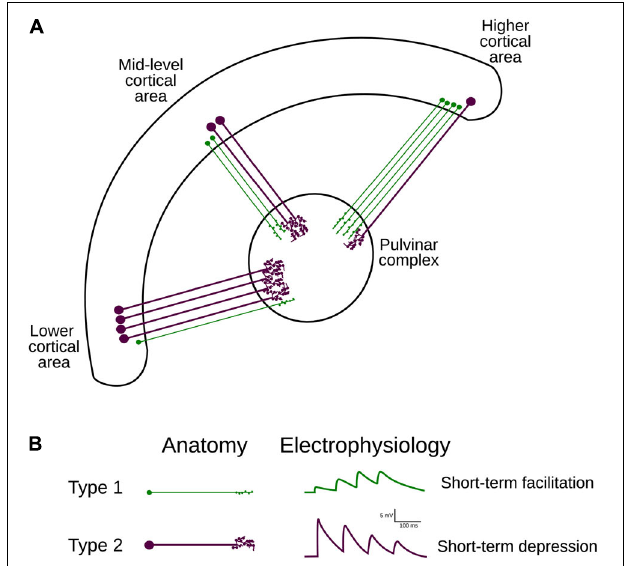
FIGURE 1 | Hierarchical organization and attributes of CT projections. (A) Two types of CT projections from lower- mid- and higher-ranked cortical areas target the pulvinar. Note the variation of proportions of type 1 (from layer VI) and 2 (from layer V) axons along the visual cortical hierarchy ( Table 1 ). (B) Anatomical (left panel) and functional (right panel) classification criteria for projection types 1 and 2. Type 1 terminals have thinner axons, bear small boutons, and elicit EPSP with short-term facilitation; type II projections have thicker axons, larger boutons that can form rosette-like structures and produce EPSP with short-term